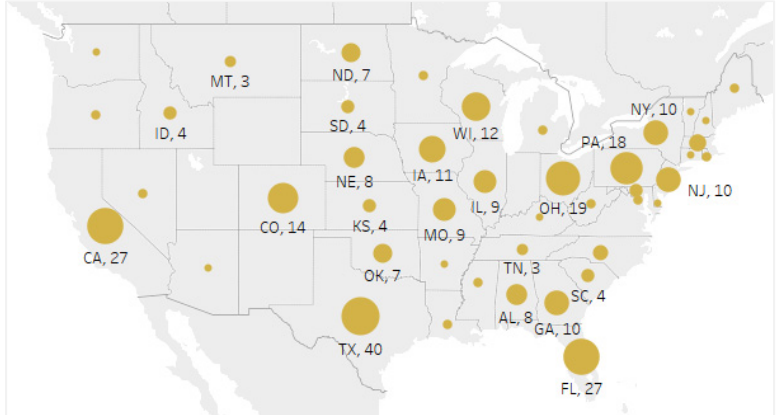
Figure 1. Locations of skid steer-related fatalities and severe injuries, 2015–2020 (Magnitude of circles are proportional to the number of injuries).